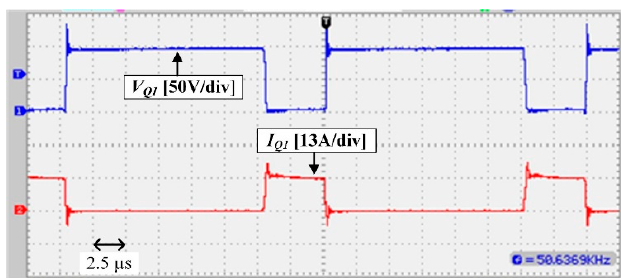
Figure 13. Voltage and current waveform of the switch Q.